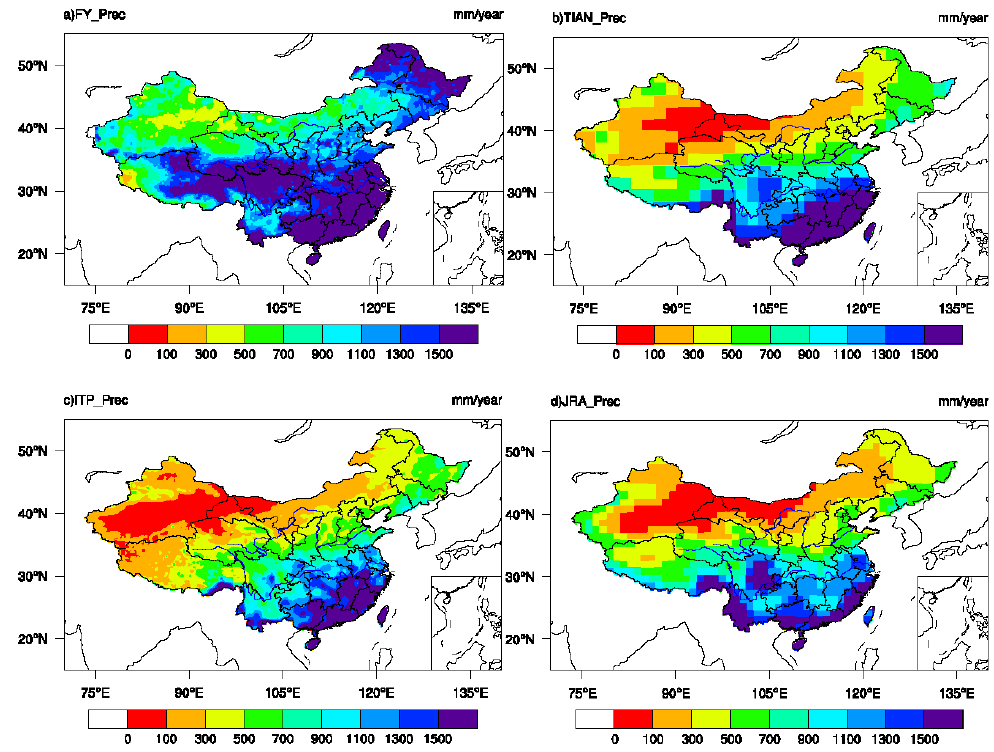
Fig. 3. Precipitation (mmyr − 1 ) averaged for July 2005–June 2010 from: (a) FY; (b) TIAN; (c) ITP; (d) JRA. Fig.3. Precipitation (mm/year) averaged for July 2005 – June 2010 from: (a) FY; (b) 692 The four sets of simulated soil-moisture data were TIAN; (c) ITP; (d) JRA. 693